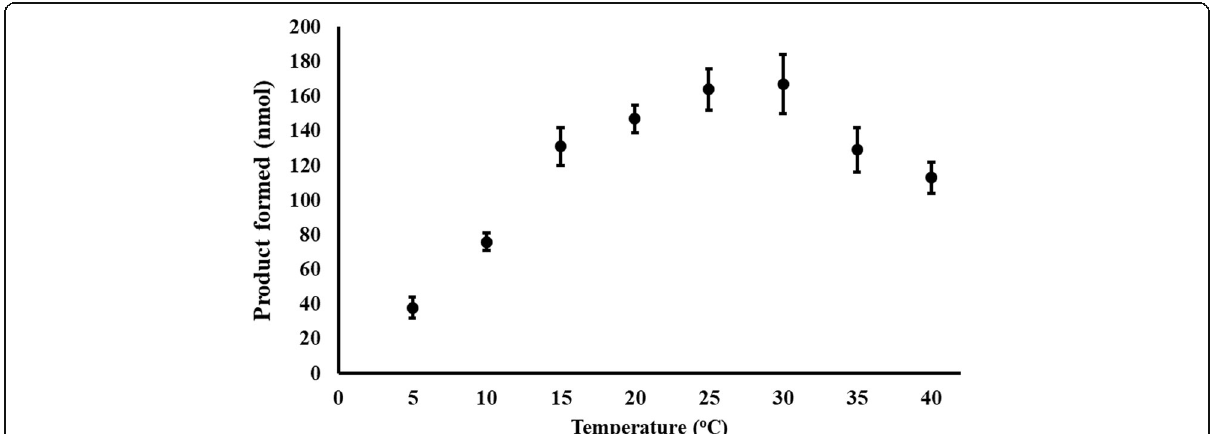
Fig. 3 Thermal profile of the lysis of fluorescently labeled fatty acids from the membranes of E . coli . The results represent the means ± sd of four independent trials